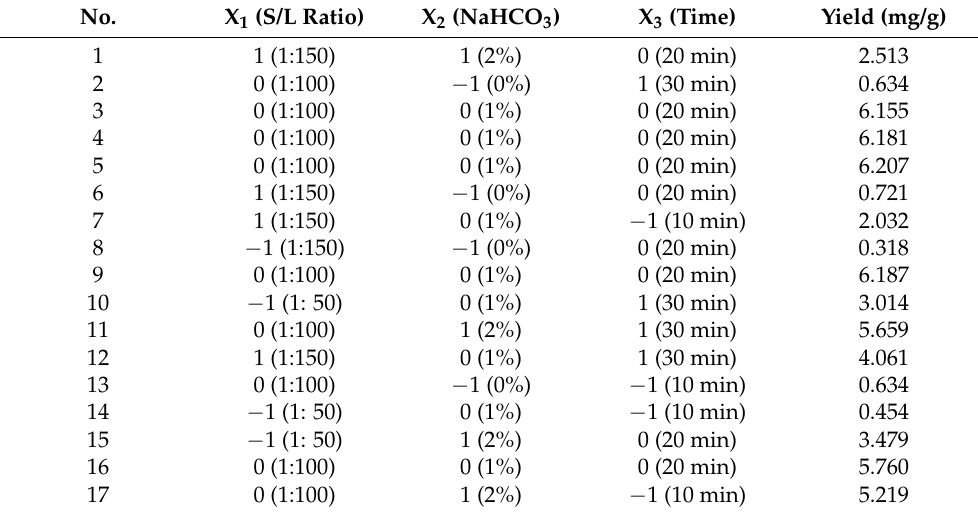
Table 1. The BBD design and results of response surface analysis.